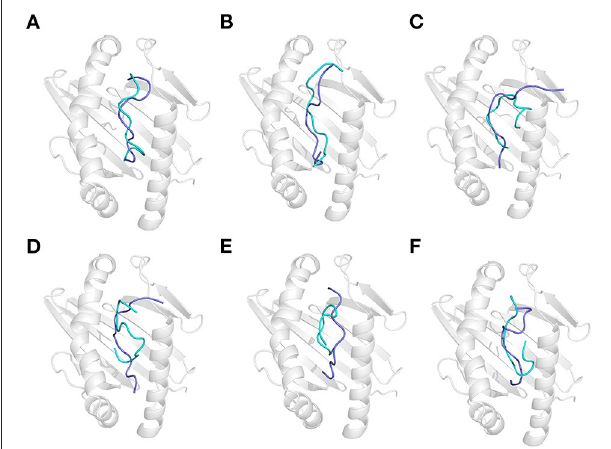
FIGURE 4 | Effect of acidic treatment on the recognition of gluten epitope peptides (GEPs). In each panel, the white cartoon representation presents the HLA-DQ2 with the epitope presenting groove facing outwards. The ribbon diagram represents each GEP. The cyan ones represent native GEPs at pH 4.5 and 25 ◦ C, and the slate ones represent the thermal treated one at pH 2.0 and 25 ◦ C. (A–F) GEP1–GEP6,